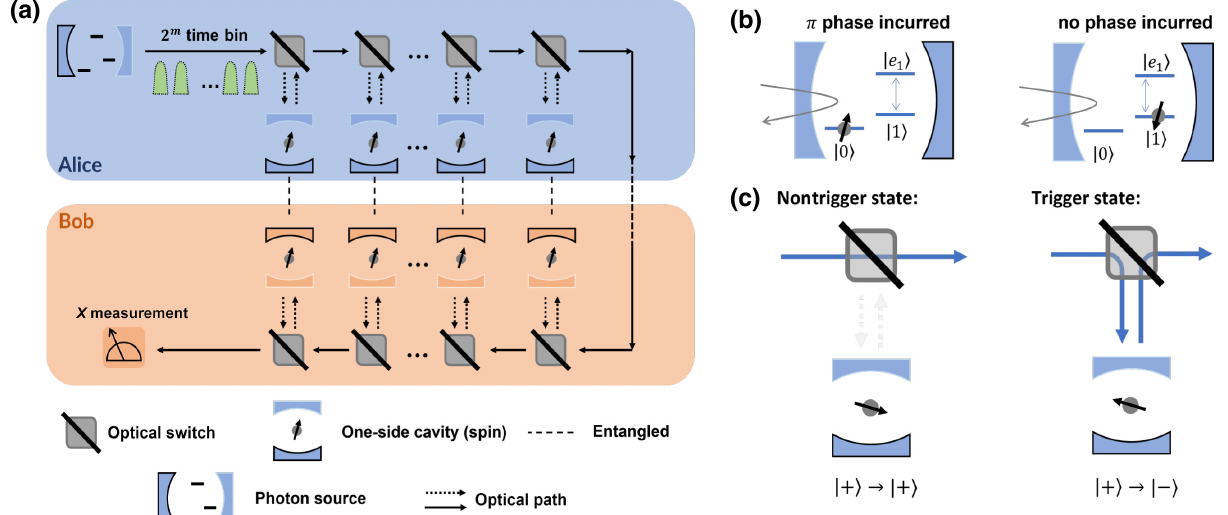
FIG. 3. (a) A possible implementation of the proposed protocol using time-bin encoded photons and quantum emitters coupled to one-sided optical cavities. A pulsed cavity-assisted Raman scheme is used to generate the photonic time-bin qudit. Optical switches will route the photon to interact with different spin-cavity systems depending on the binary encoding of the time bin. The scattering of a photon from the one-side spin-cavity system implements a spin flip, resulting in spin-photon entanglement. Interaction with both qubit registers (Alice and Bob) consecutively generates spin-spin entanglement and a final X-basis measurement of the photonic qudit heralds the successful generation of multiple entangled pairs across the two registers. (b) Photon-spin controlled- Z ( CZ ) gates. A resonant photon will be reflected (gray arrow) from the cavity-spin system with (without) a π phase shift if the qubit is in the uncoupled (coupled) state | 0 (cid:2) ( | 1 (cid:2) ). This gate is equivalent to a photon-mediated controlled- NOT ( CNOT ) gate if Hadamard gates are performed on the spin qubit before and after the interaction. (c) A sketch of the underlying mechanism behind the interaction scheme between the time-bin qudit and the qubit register. Consider a photon in time bin l , with the binary representation of l being [ l m − 1 · · · l k · · · l 1 l 0 ] 2 . If l i = 0, the i th optical switch will let the photon pass through without interaction with the i th cavity-spin system. If l i = 1, the optical switch will instead route the photon to the cavity and flip the spin state through the interaction pictured in